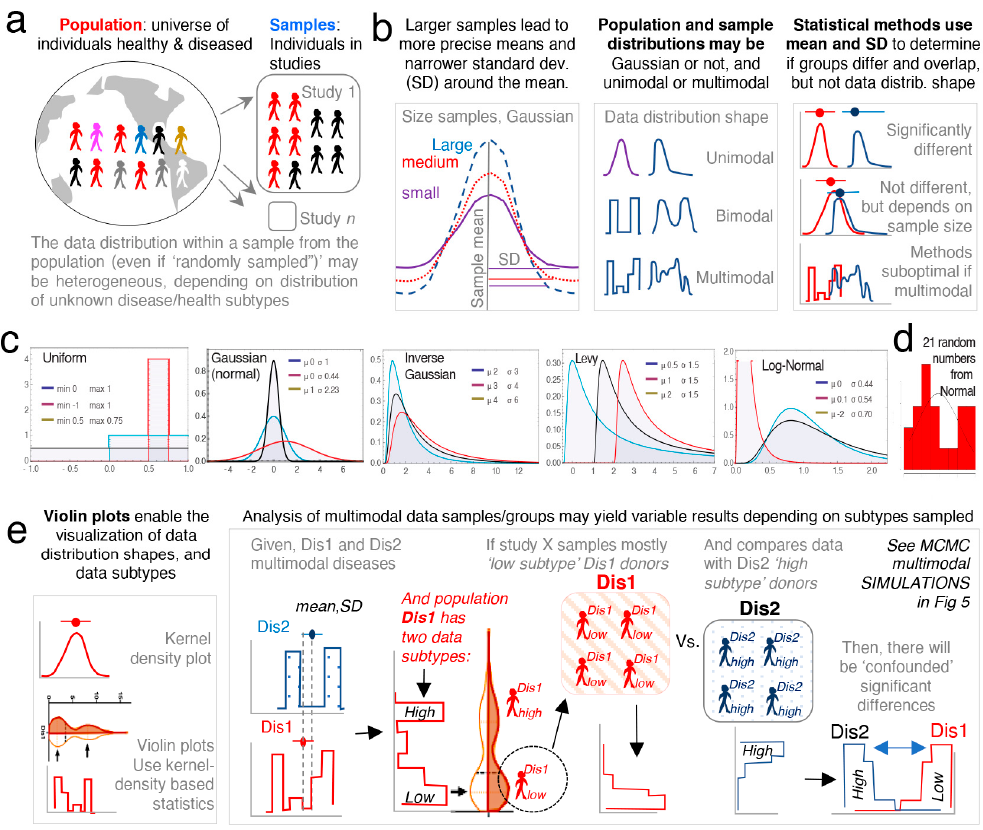
Figure 4. Conceptual overview of the effect of random sampling and analysis of multimodal data. ( a ) Schematic conceptualization of random sampling from a population of heterogeneous individuals. ( b ) Representation of various unidimensional data distributions. Notice that mean and SD do not represent the shape of the distribution. ( c ). Examples of probability density functions of unimodal distributions. Wolfram language [80]. ( d ) Example of a random sampling of numbers generated in this study using decimal Gaussian distribution generates a non-Gaussian distribution (bimodal; two peaks/modes, as in disease distribution subtypes). This illustrates that even under seemingly unbiased circumstances (randomness), a set of random subjects from a population may be of two subtypes and not represent the population in its “universe” of disease possibilities. ( e ) Multimodal distributions. Use of violin and kernel plots to visualize